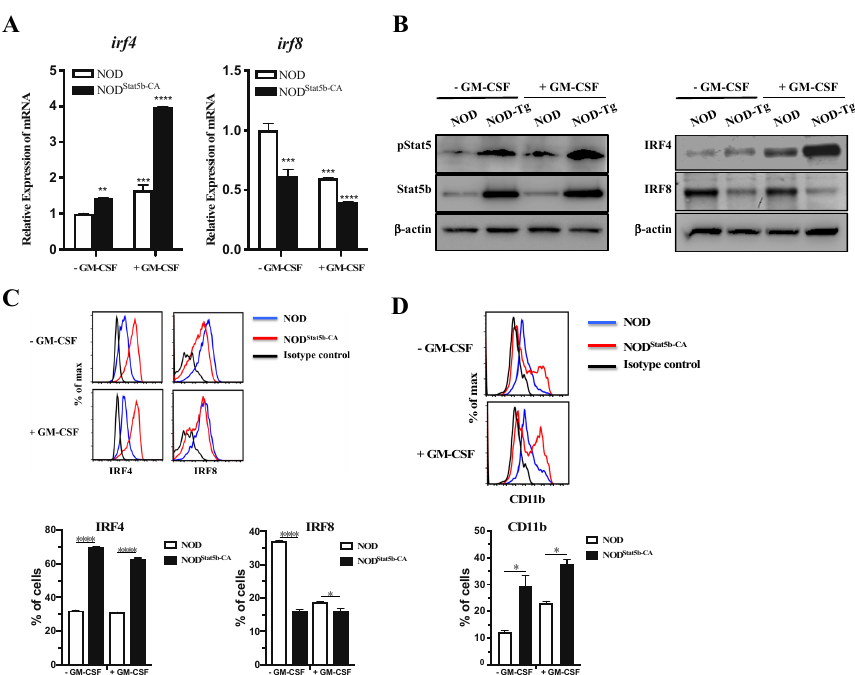
Figure 4. IRF4 and IRF8 expression is differentially regulated in Stat5b-CA-expressing BMDCs. BMDCs derived from NOD and NOD.CD11c Stat5b-CA mice were cultured for 48 h in the absence or presence of GM-CSF (50 ng/mL). ( A ) Irf4 and Irf8 mRNA expression levels were determined by qRT-PCR using the ΔΔ CT method. The data are shown as relative expression compared to untreated BMDCs derived from NOD mice. ( B ) Representative Western blot analysis of IRF4, IRF8, pStat5, and Stat5b expression. β -actin expression is shown as a gel-loading control. ( C – D ) Representative flow cytometry analysis of ( C ) IRF4 and IRF8, and ( D ) CD11b in CD11c + BMDCs. Data are shown as the mean ± SEM of at least three independent experiments. The asterisks indicate statistically significant differences determined by one-way ANOVA with Tukey’s post-test. p < 0.05 (*), p < 0.01 (**), p < 0.001 (***), and p < 0.0001 (****).